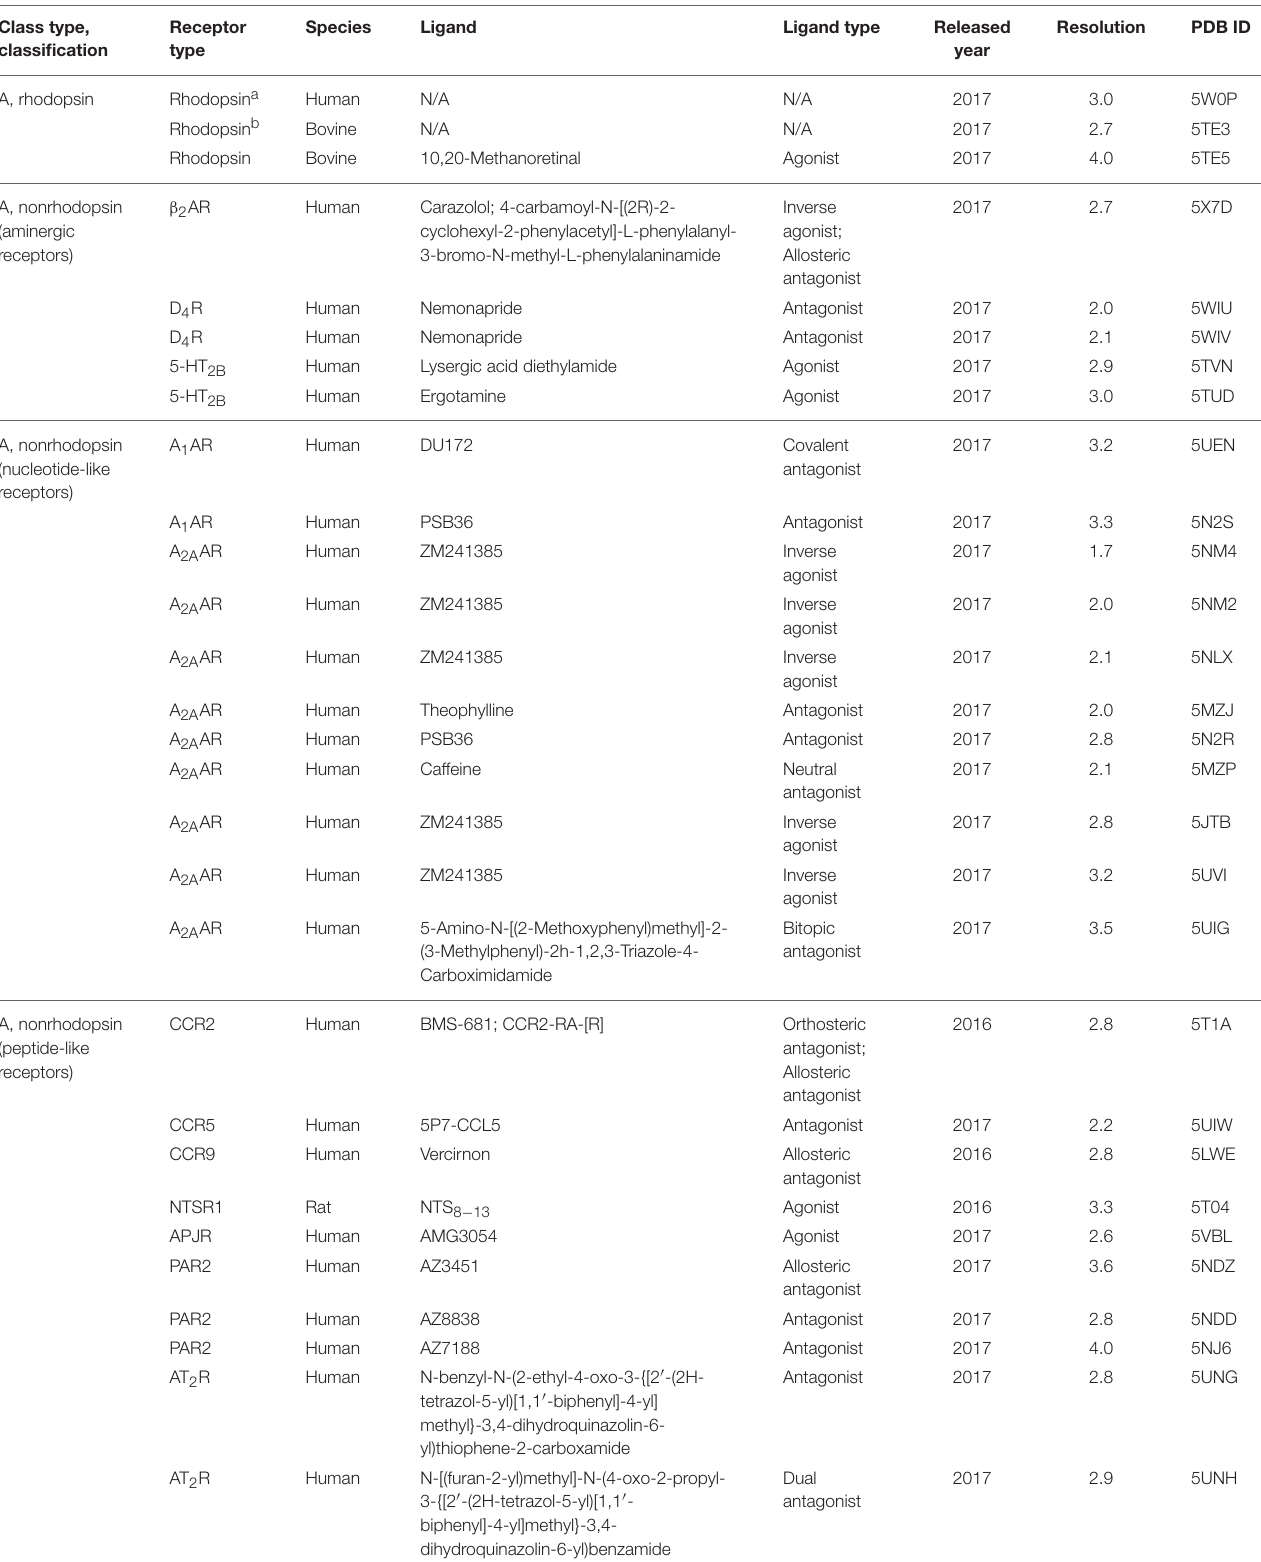
TABLE 2 | Summary of GPCR solved structures released in the past 1 year (Dec ‘16-Nov ‘17). Class type,